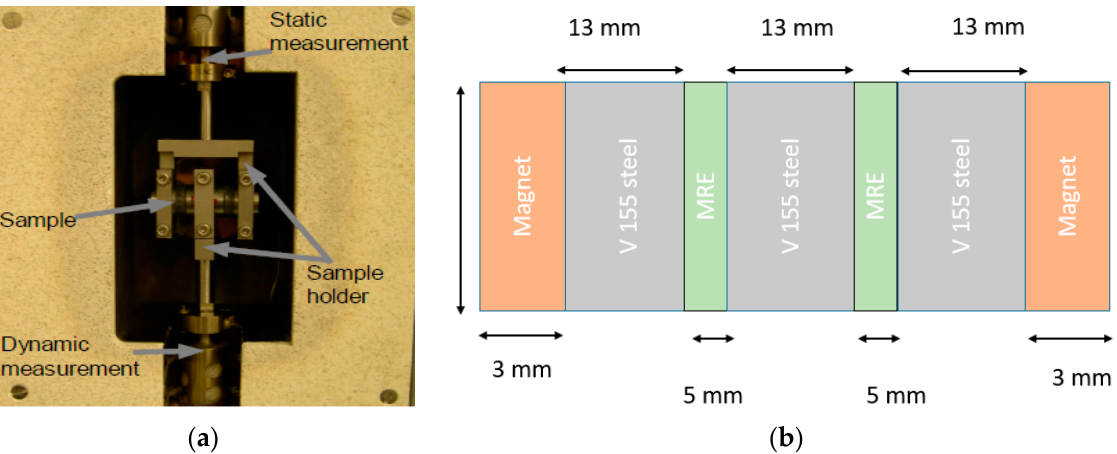
Figure 2. ( a ) Sample preparation in the dynamic mechanical analyzer. ( b ) A sketch of the sample with applied magnets at the edges of the sample.